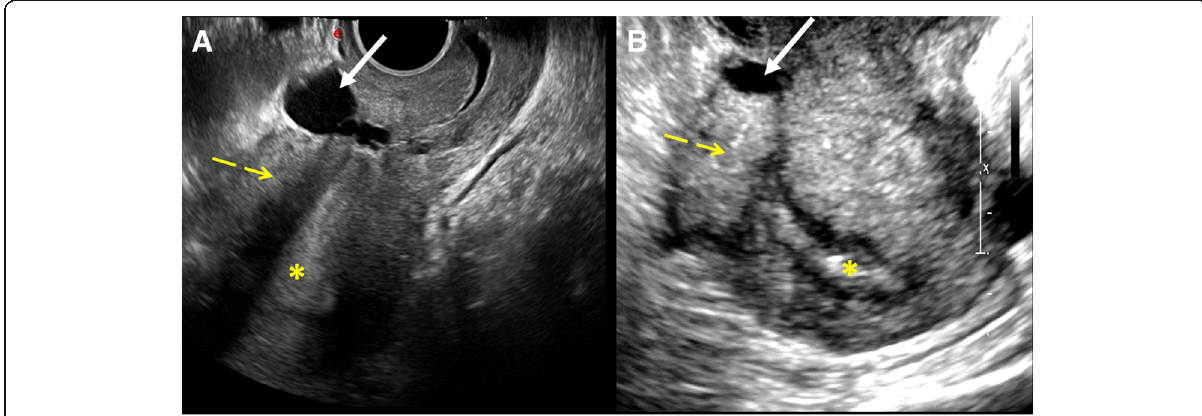
Fig. 6 Cesarean scar defect: CSD appearance at TV-US examination (white arrow). It can look like a cystic lesion ( a ) or it can be an anechoic, triangular shape defect with apex pointing anteriorly, located at the anterior isthmus ( b ). Anterior uterine wall (yellow dashed arrows), endometrium